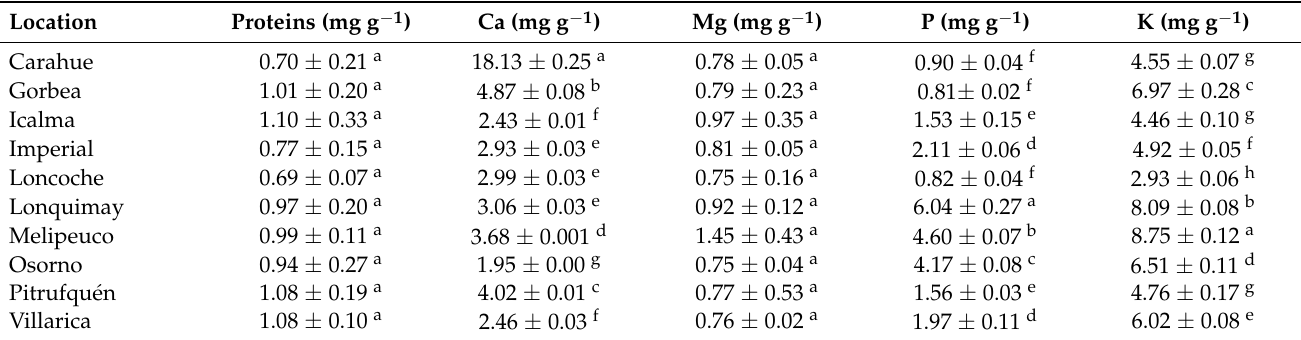
Table 1. Determination of protein by the Kjeldahl method, minerals (Mg, Ca and K) by atomic absorption spectrophotometry and phosphorus by a colorimetric method in rosehip fruits. Different letters in each sub-figure indicate the presence of statistically significant differences according to the Tukey’s multiple range test ( p ≤ 0.05; n = 9).